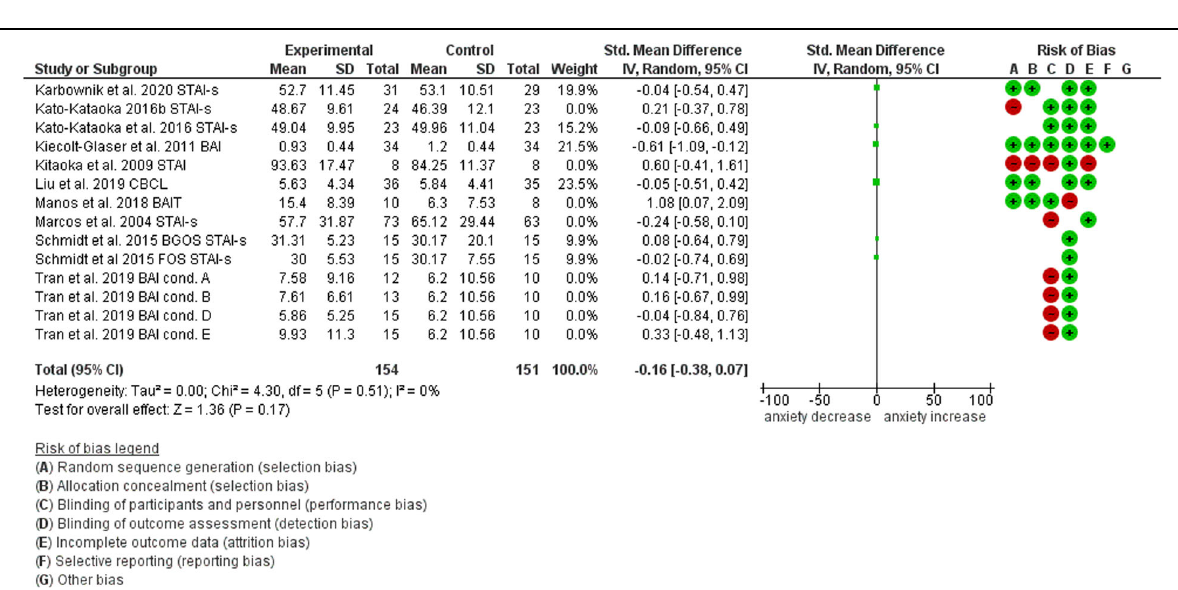
Fig. 4 Forest plot excluding the studies at high risk of bias. Reasons for high risk are as follows: A Marcos et al. 33 : concerns in regards to the randomization and allocation sequence and non-blinded design; B Kitaoka et al. 39 : unclear anxiety score differences at baseline between the active and control group, absence of a participants fl ow diagram and of any relevant information about intervention adherence and missing data; C Manos et al. 36 : unclear anxiety score differences at baseline between active (severe anxiety levels) and control (moderate anxiety levels) groups, not speci fi ed reasons for no intervention adherence and missing data, no measurement of state anxiety; D Kato-Kataoka et al. 29 : no randomized allocation, signi fi cantly different anxiety scores at baseline ( p < 0.05) between the active and control group; E Tran et al. 30 : concerns in regard with randomization and allocation process, not enough information about adherence to the intervention and missing data, concerns about the performed statistical